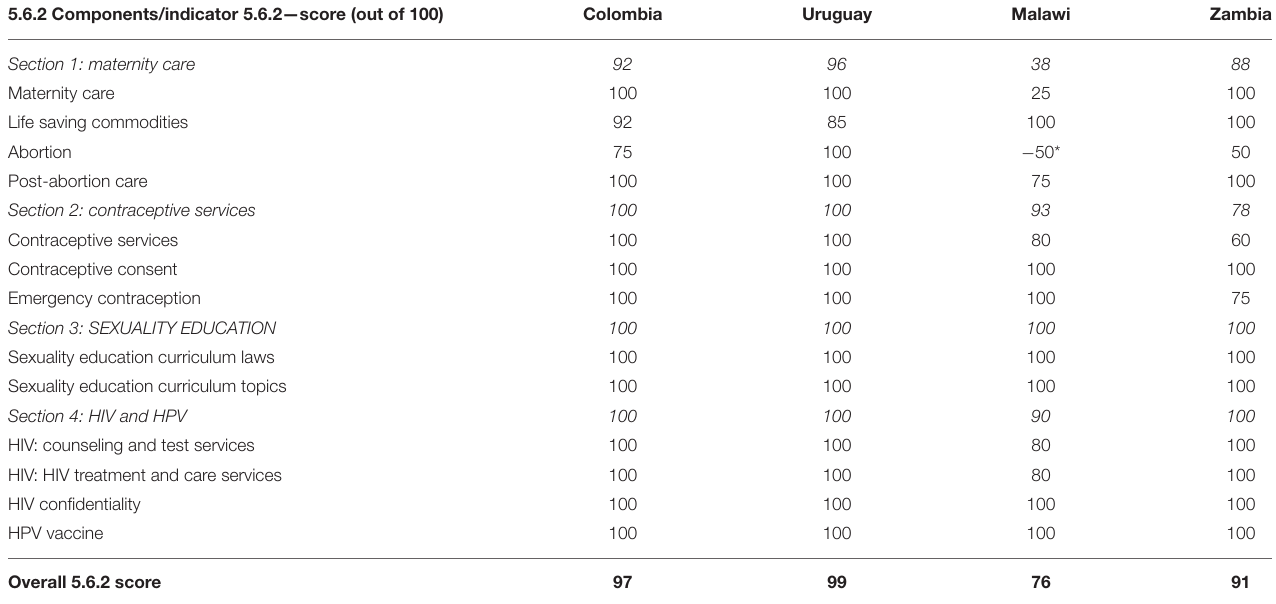
TABLE 2 | Overview of SRH-related laws